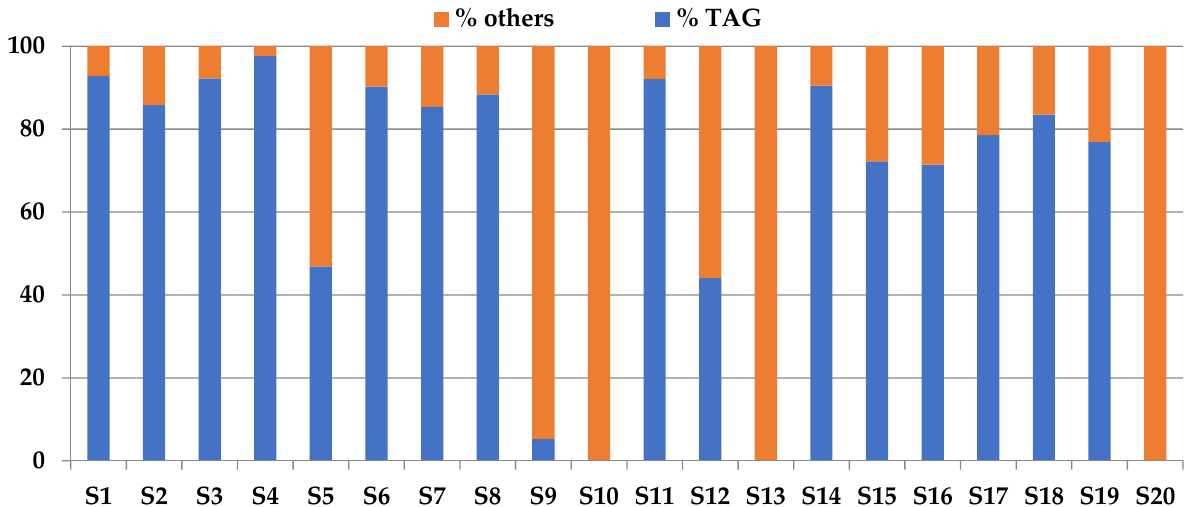
Figure 2. Relative content (%) of triglycerides (TAG) and other lipids in the samples ( n = 3). The TAG range content was 0–97.6%. Samples S10, S13, and S20 did not contain TAG because they were formulated with concentrated fish oil containing ethyl esters of EPA and DHA. Sample S5 showed a TAG content of 47%; this low content was strictly